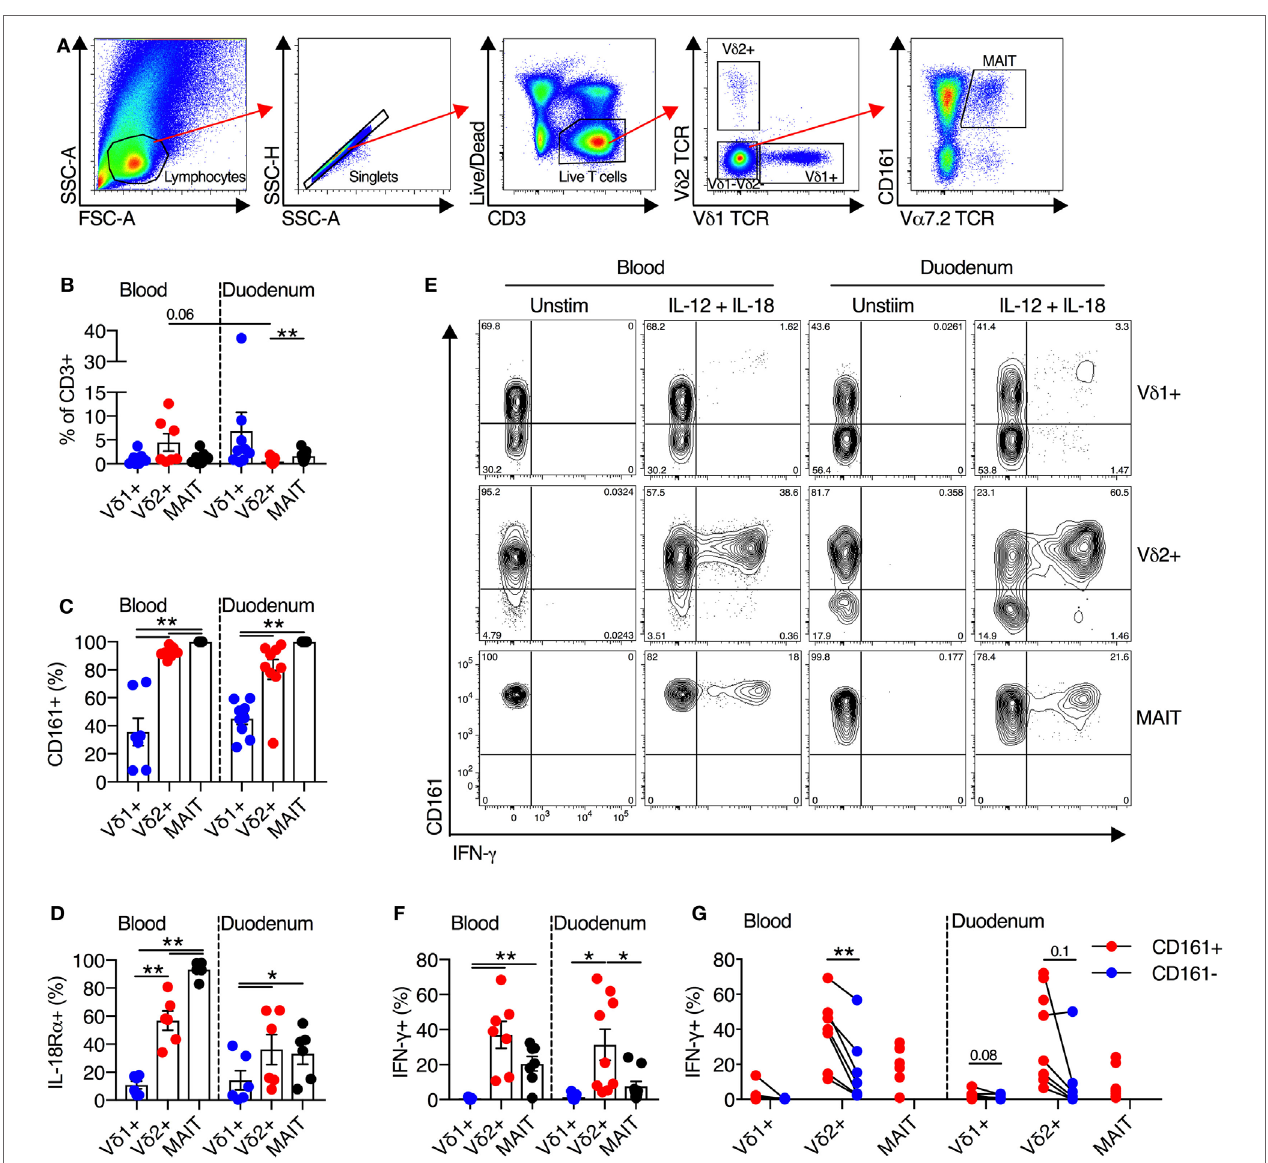
FigUre 4 | Human duodenal V δ 2 + γδ T cells maintain innate-like phenotype and function. Intestinal mononuclear cells were isolated from biopsies of human duodenal tissue and matched blood. (a) Representative gating scheme for the identification of V δ 1 + γδ T cells, V δ 2 + γδ T cells, and mucosal-associated invariant T (MAIT) cells. (B) Frequency of V δ 1 + γδ T cells, V δ 2 + γδ T cells, and MAIT cells as a fraction of all CD3 + T cells in duodenum and matched blood. (c) Expression of CD161 on blood and matched duodenal V δ 1 + γδ T cells, V δ 2 + γδ T cells, and MAIT cells. (D) Expression of IL-18R α on blood and matched duodenal V δ 1 + γδ T cells, V δ 2 + γδ T cells, and MAIT cells. (e–g) Blood and duodenal mononuclear cells were stimulated for 20 h with IL-12 and IL-18 (50 ng/ml). Brefeldin A and Monensin were added for the final 4 h. (e) Representative FACS plots of IFN- γ production by V δ 1 + γδ T cells, V δ 2 + γδ T cells, and MAIT cells. (F) Production of IFN- γ by each cell subset. (g) Production of IFN- γ segregated by CD161 expression for each cell subset. Note: three individuals had 100% CD161 + in the V δ 2 + γδ T cell population, hence the lack of a paired comparator population. Mean ± SEM. Symbols represent individual donors ( N = 8–9), pooled from four independent experiments. ** P < 0.01; * P < 0.05. Repeated measures paired ANOVA with correction for multiple comparisons (B–D,F) and paired T test (g)